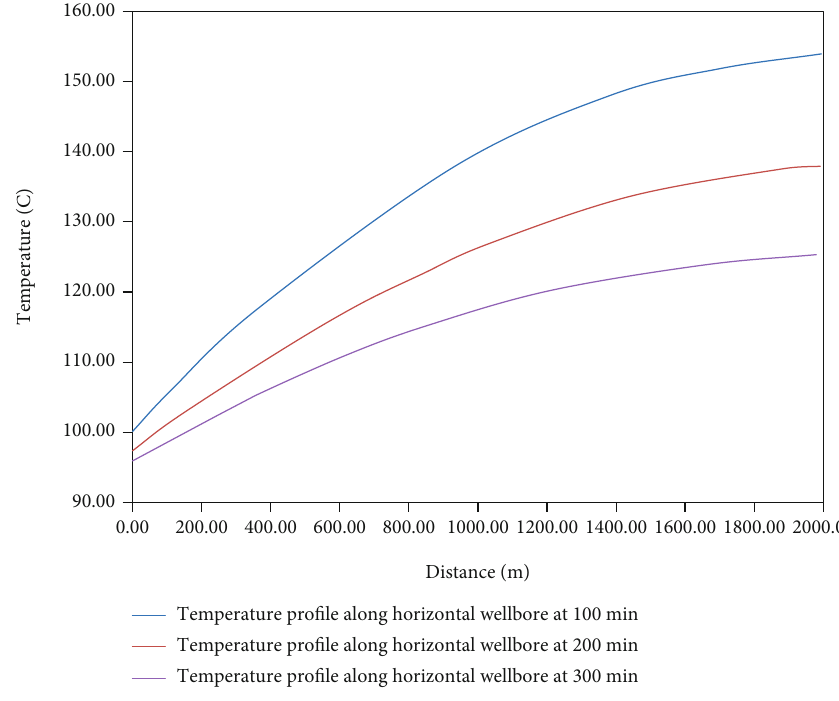
Figure 7: Formation temperature pro fi le at the wellbore along horizontal segments at di ff erent pumping times.